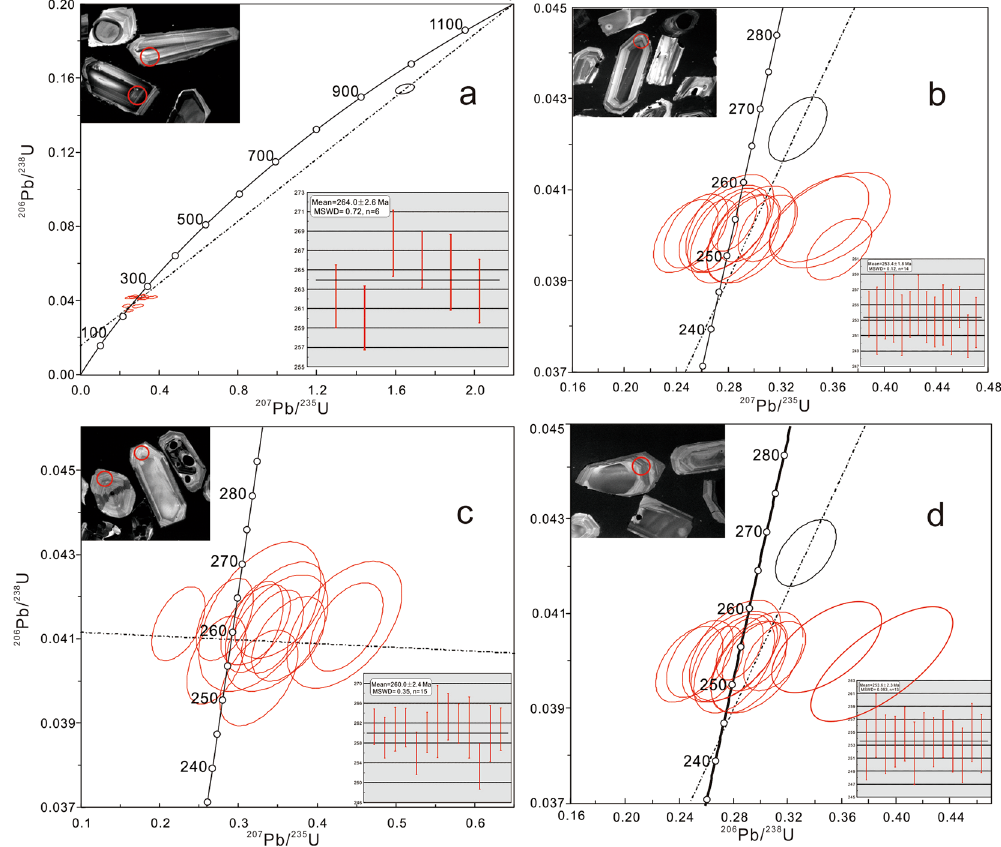
Figure 2. U-Pb Concordia diagrams for ( a ) CH-1, ( b ) CH-2, ( c ) SS-1, ( d )